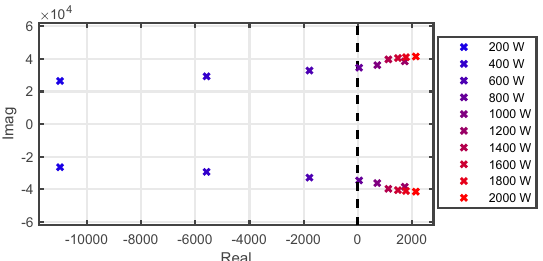
Figure 10. Pole-pair that shifts from LHP to RHP as the output power